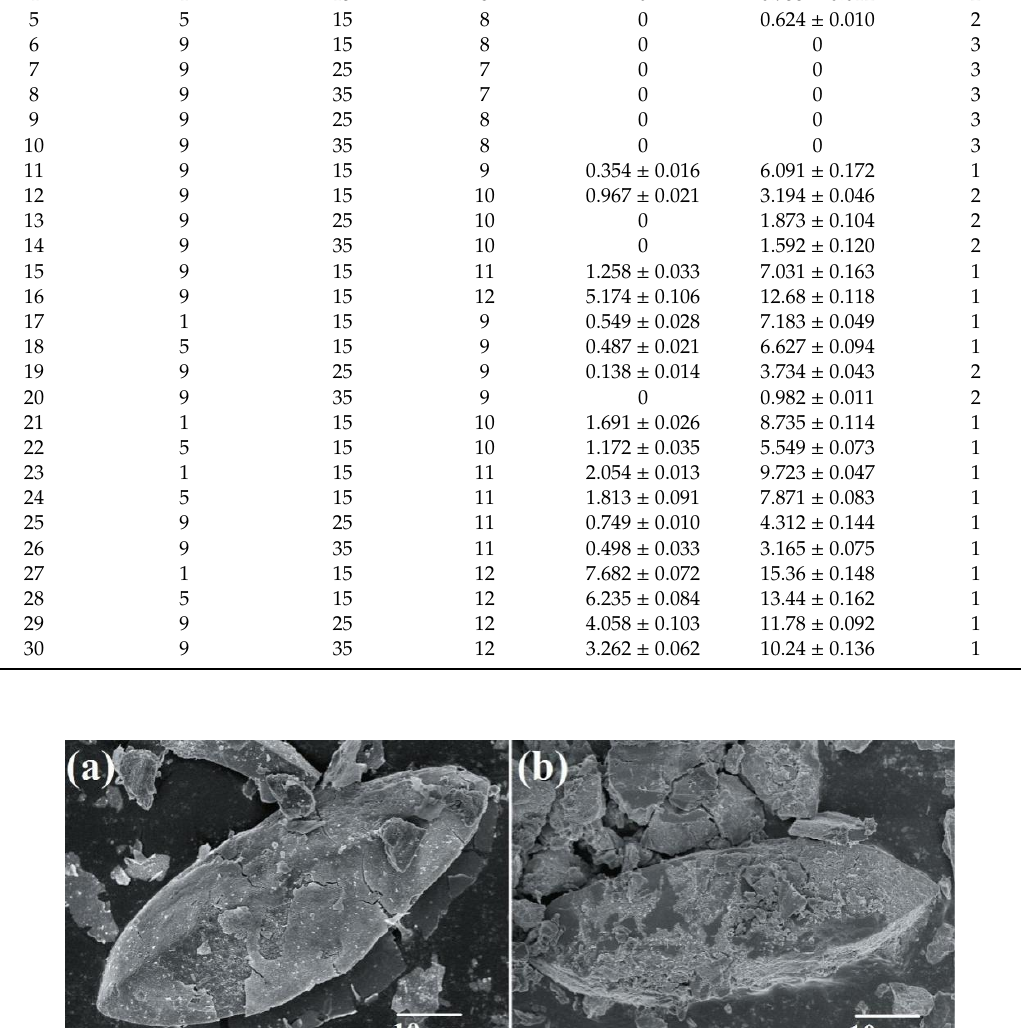
Table 2. Stability evaluation results of synthesized scorodite@Fe 3 O 4 under di ff erent conditions (toxicity characteristic leaching procedure (TCLP) 1: pH = 4.93, 18 h; TCLP 2: pH = 9.30, 24 h; 3 stars is the highest and 1 star is the lowest quality).